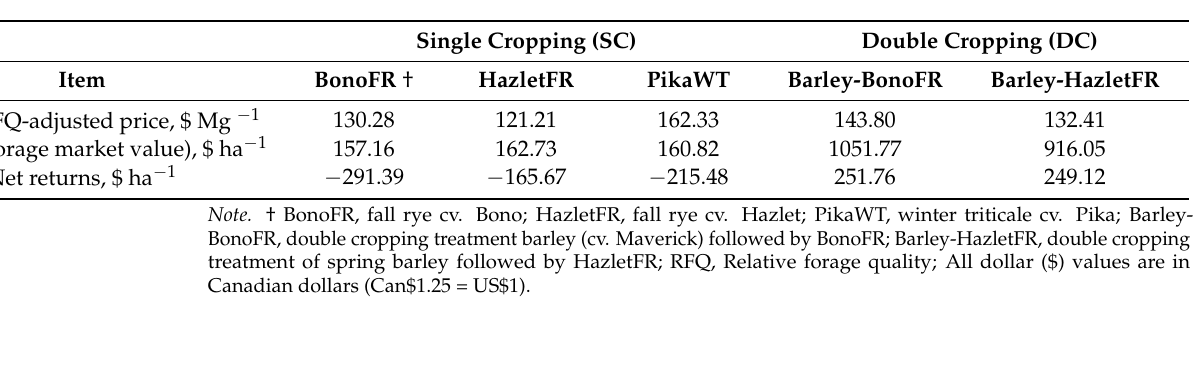
Table 10. Returns and net returns of winter cereals in single and double cropping systems over 2